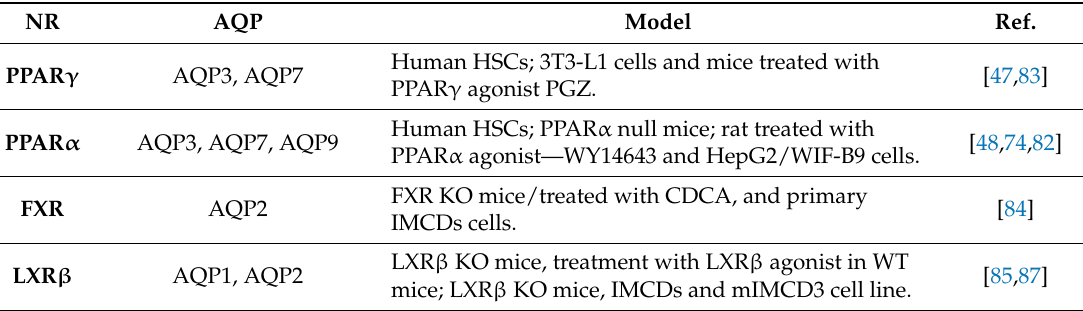
Table 2. Nuclear receptor (NR) regulation of AQP